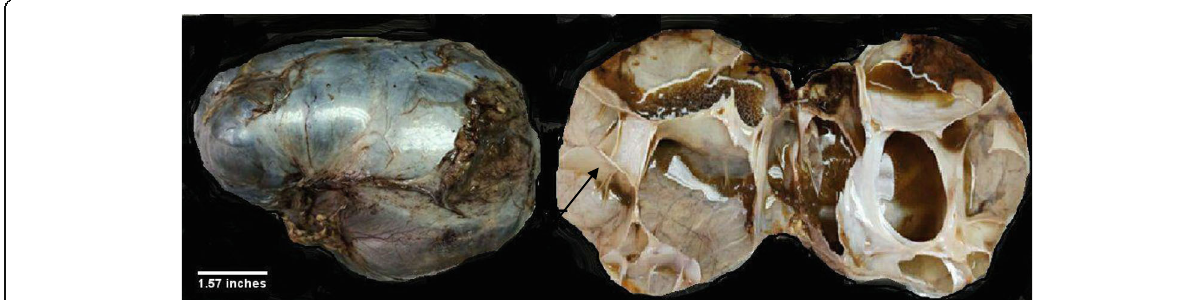
Fig. 2 Showing external (left) and cut surface(right) gross photographs of a 17x10x4 cm encapsulated tense bosselated cystic lesion with smooth inner walls and mucinous fluid, which on histopathology was found to be a Mucinous Cystadenoma (black arrow showing the thin internal septations)